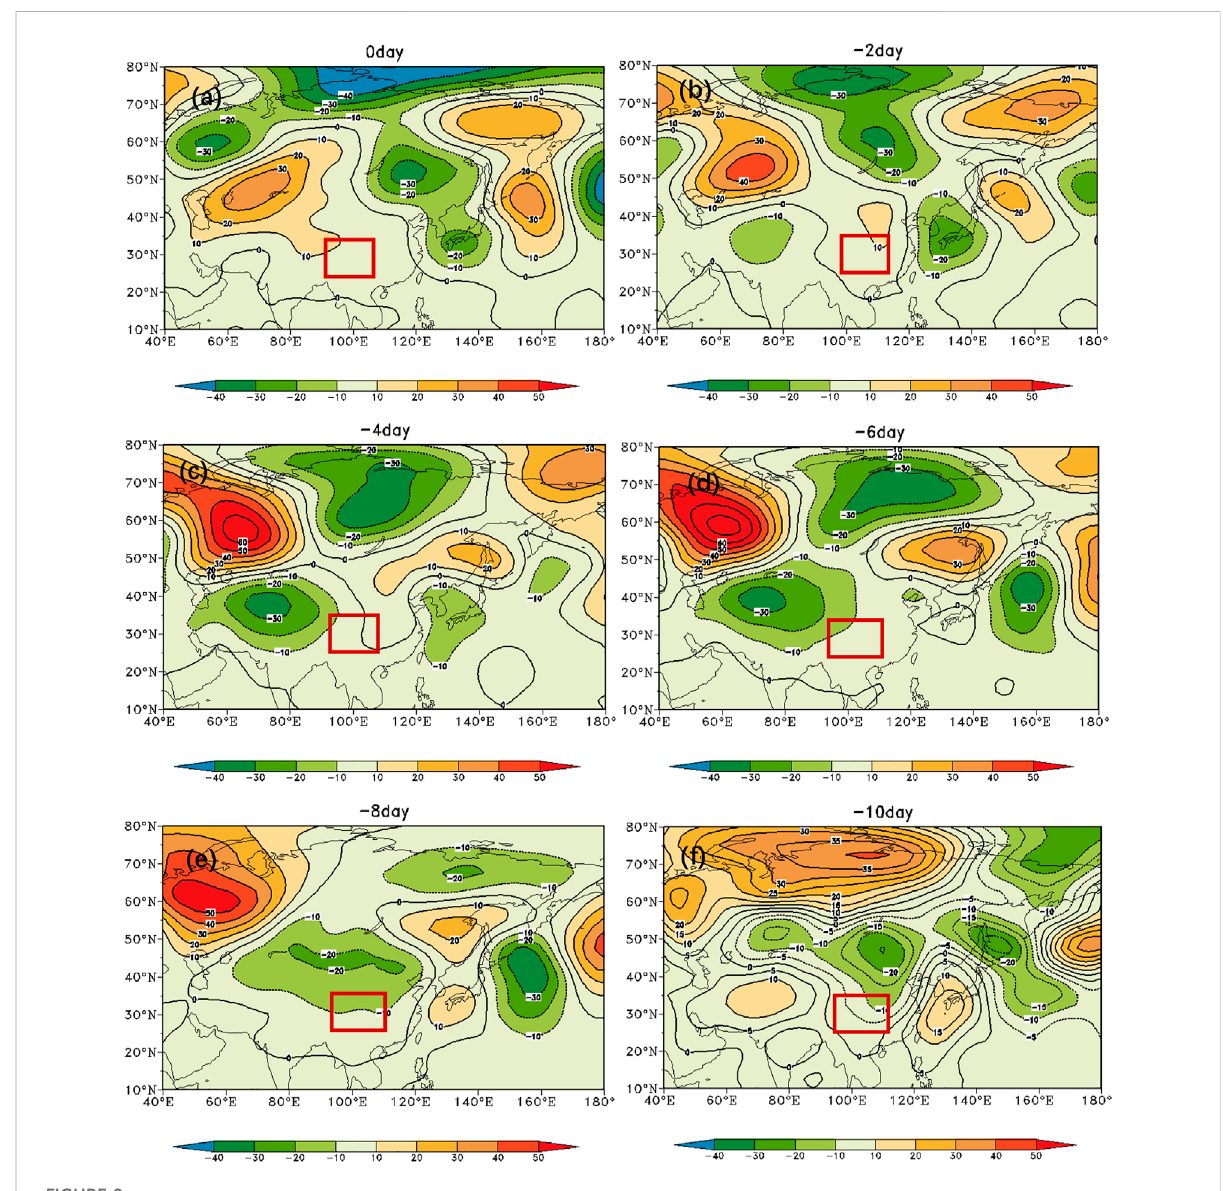
FIGURE 9 Evolutionofthelow-frequency(15 – 30 days)geopotentialheightanomalyat500 hPafrom10daysbeforetheprecipitationto0 dayafteronset in East Sichuan, unit: